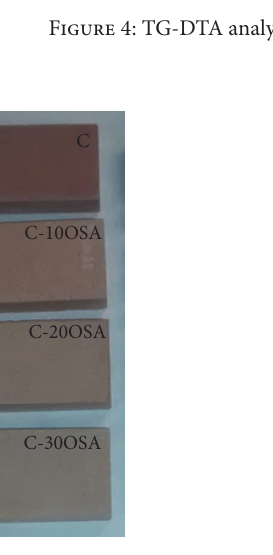
Figure 6: Bulk density of the fired bricks as function of olive stone ash